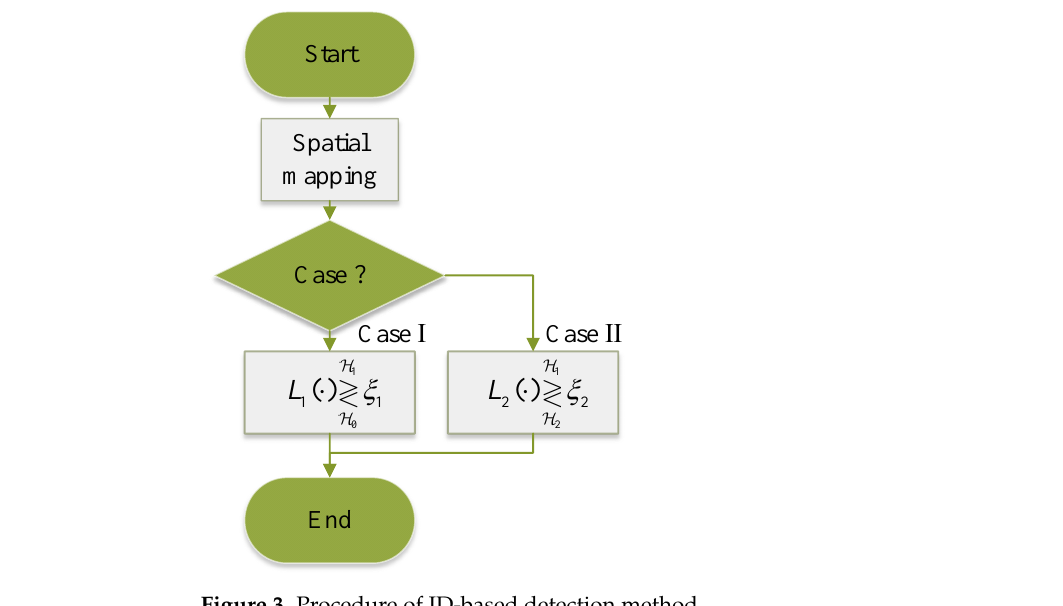
Figure 3. Procedure of ID-based detection